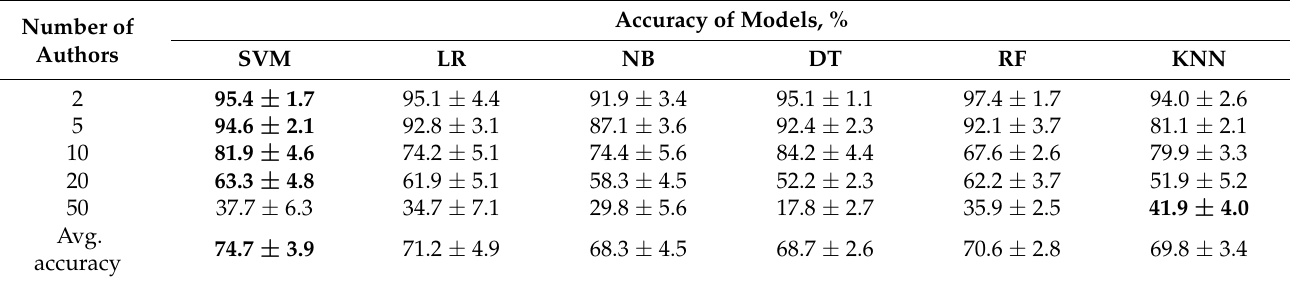
Table 3. Results of author identification using ML trained on the feature